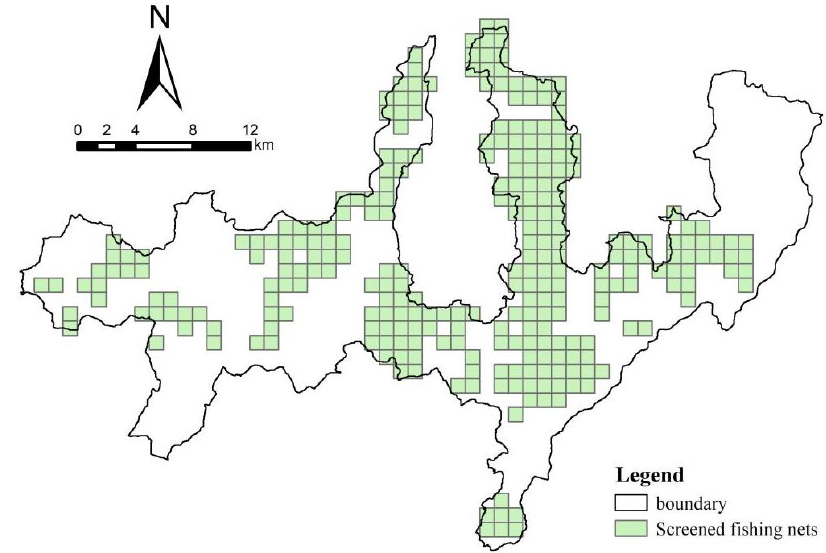
Figure 5. Sample patches. Table 4. List of landscape-pattern-index